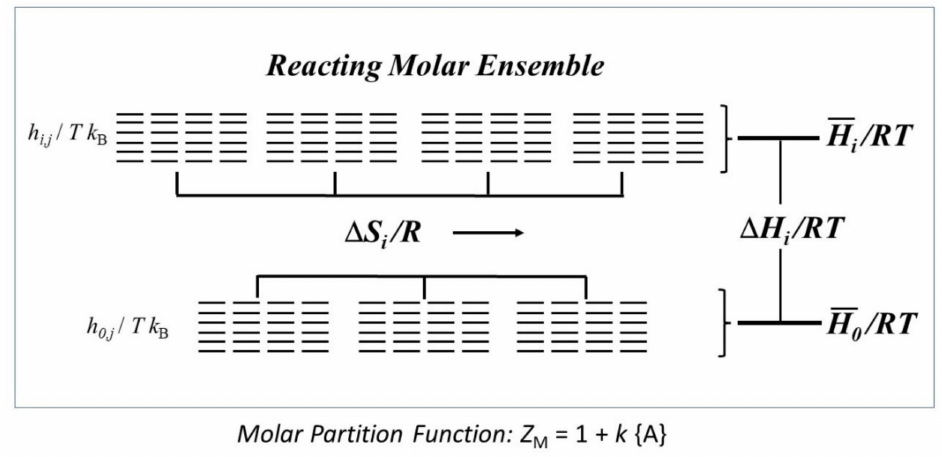
Figure 4. The distribution of moles over each macrolevel H i follows a binomial mathematical distribu- tion, not calculated by integration. Now, we have two methods for calculating partition